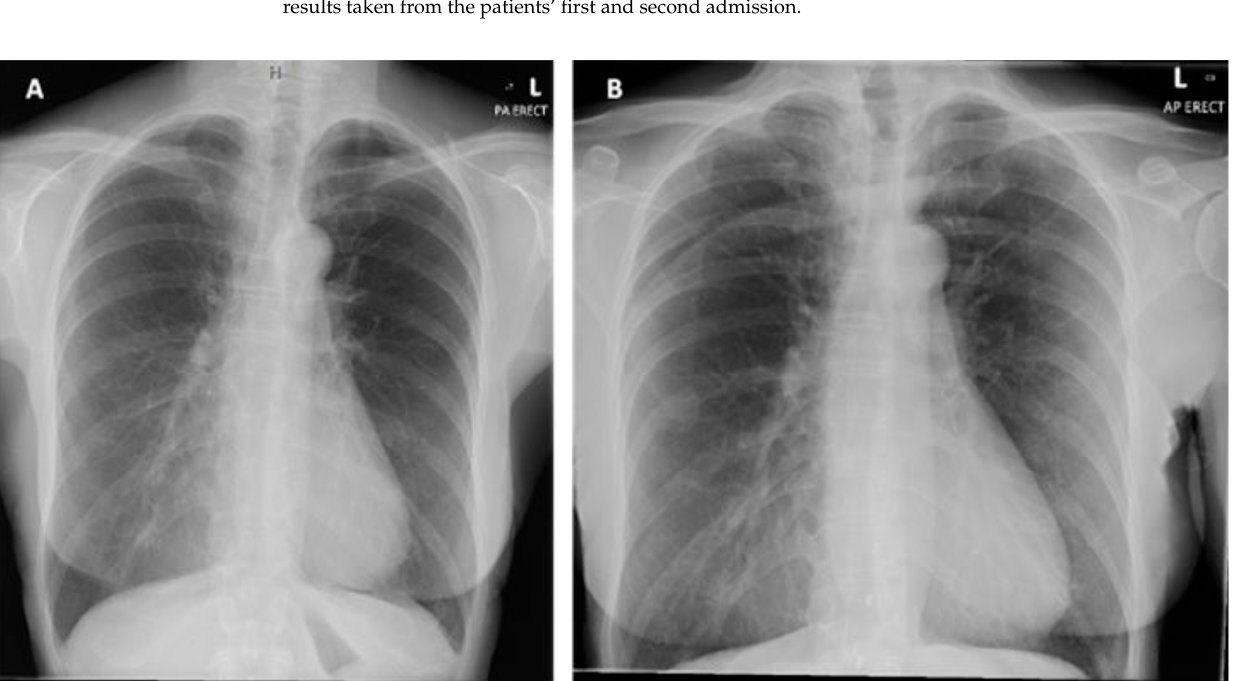
tion rate, CRP—C-reactive protein; H—higher than normal range, L—lower than normal range. The red borderline delineates the blood results taken from the patients’ first and second admission.